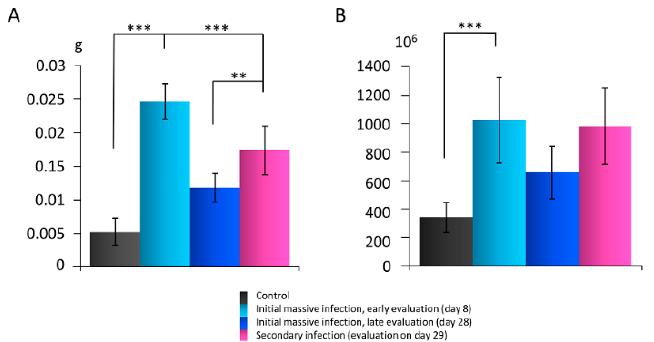
Figure 2. Rat popliteal lymph nodes after S. epidermidis skin infection ( n = 32 rats, 64 nodes). ( A ) Changes in the lymph node mass (g). ( B ) Changes in the lymph node immune cell number. Results are presented as mean ± standard deviation (SD). ** p < 0.01; *** p < 0.001.